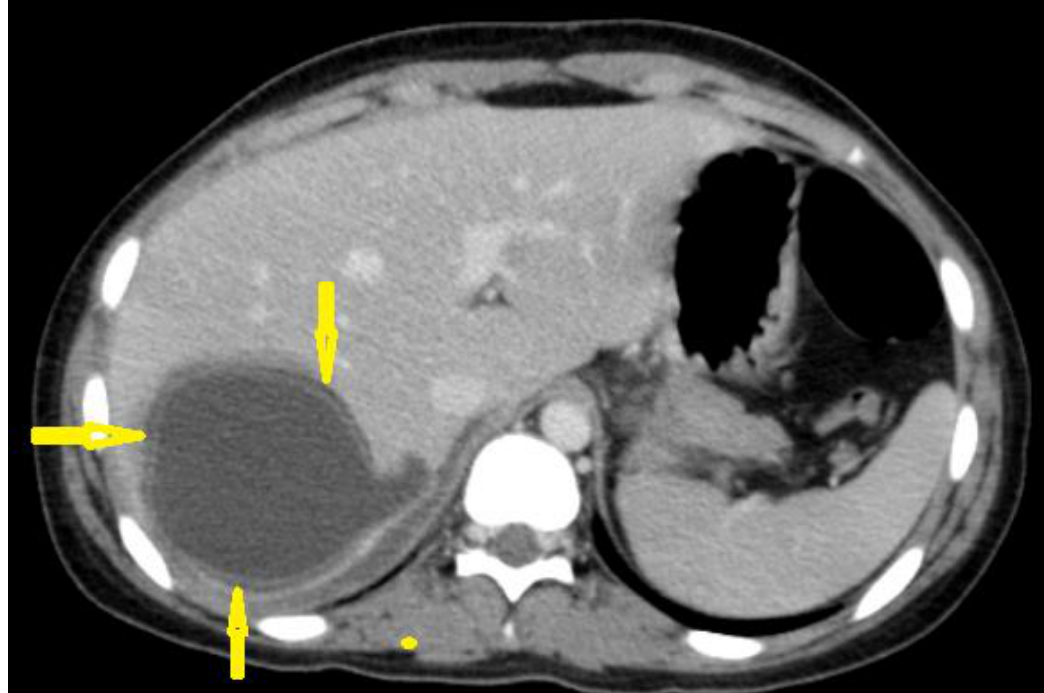
Figure 3. Contrast-enhanced computed tomography of a 15-year-old female presenting with abdomi- nal pain showing a well-circumscribed, unilocular, non-enhanced cystic lesion in the right lobe of the liver with typical “double-wall sign” of hydatid cyst